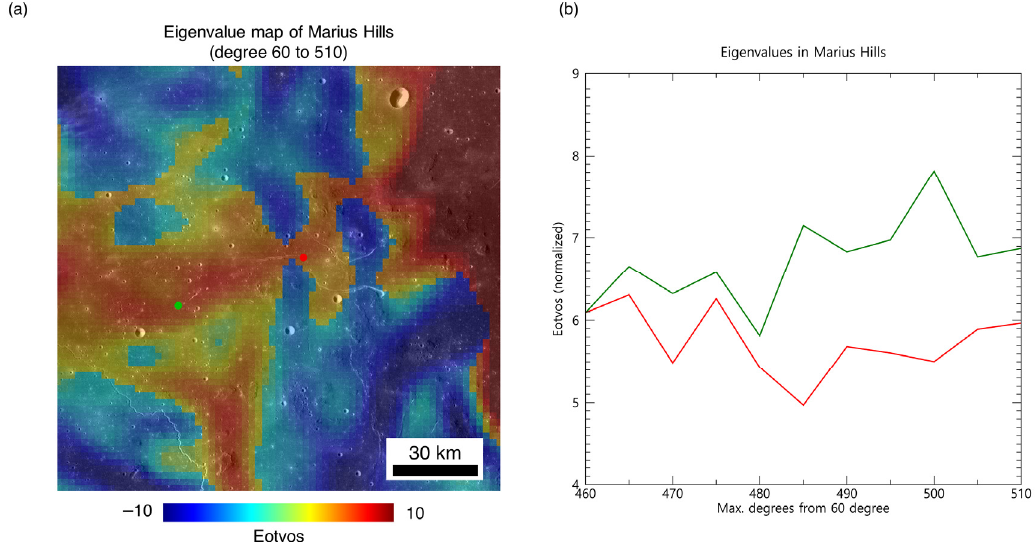
Figure 4. Eigenvalues map of Marius Hills Hole (MHH) region and eigenvalue variation of two pit locations. ( a ) A mass deficit (red color) appears in the rille area of the two pits. ( b ) As the eigenvalue variation for two pit points, the color of each plot corresponds to the color of the dot in ( a ). The increasing trend of MHH (red) appears after 483 SH degrees, and the positive trend is not clear compared to the green point. The graph is normalized at 460 degrees to make it easier to see the trend change. We identified the terrain using a Lunar Reconnaissance Orbiter Camera (LROC) Wide Angle Camera (WAC) image in ( a ).